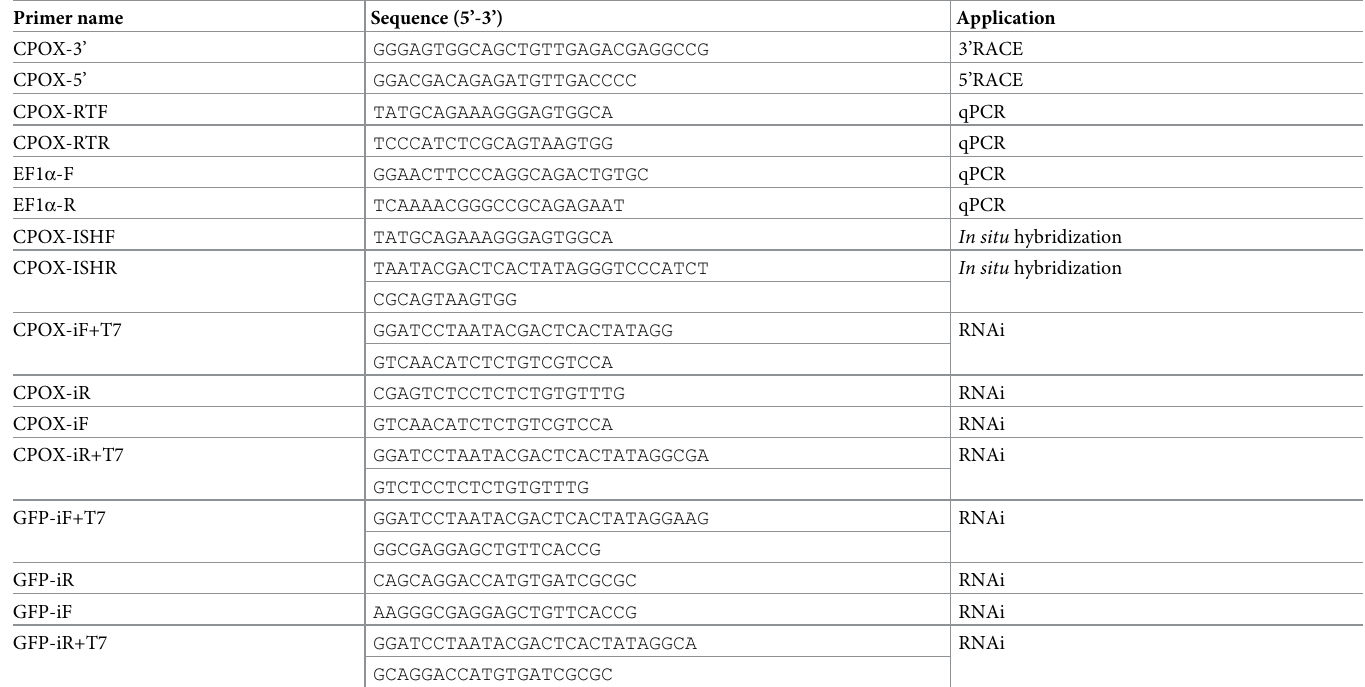
Table 1. Primers used in this